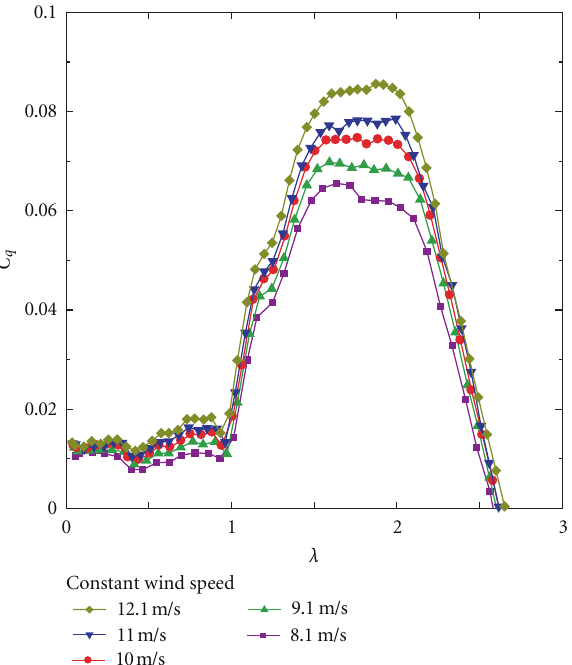
Figure 4: Torque coe ffi cients, C q ( λ ), for a VAWT with NACA 0012